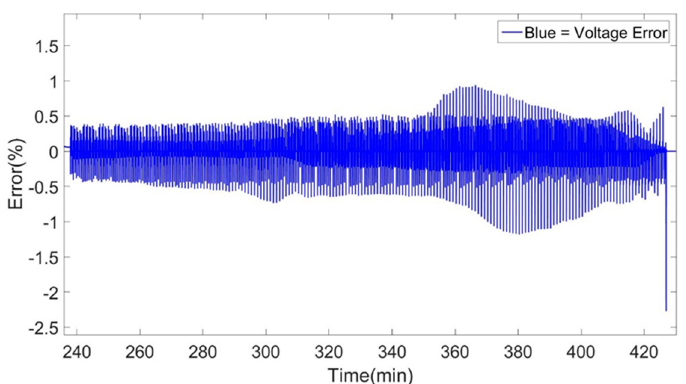
advanced Kalman filtering and advanced characterization.